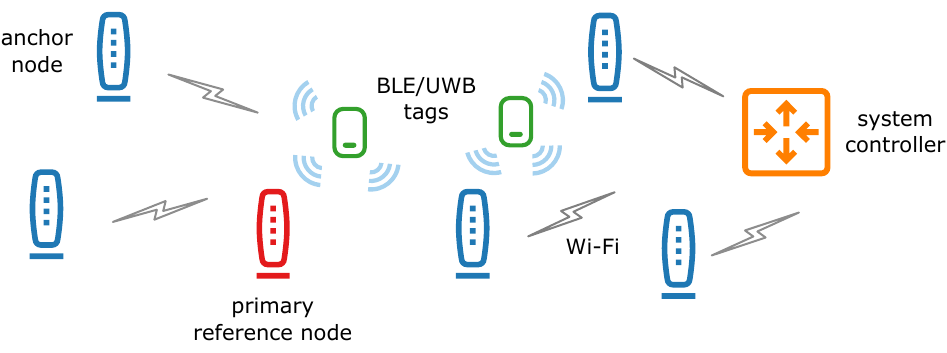
Figure 1. Localization system functional architecture.